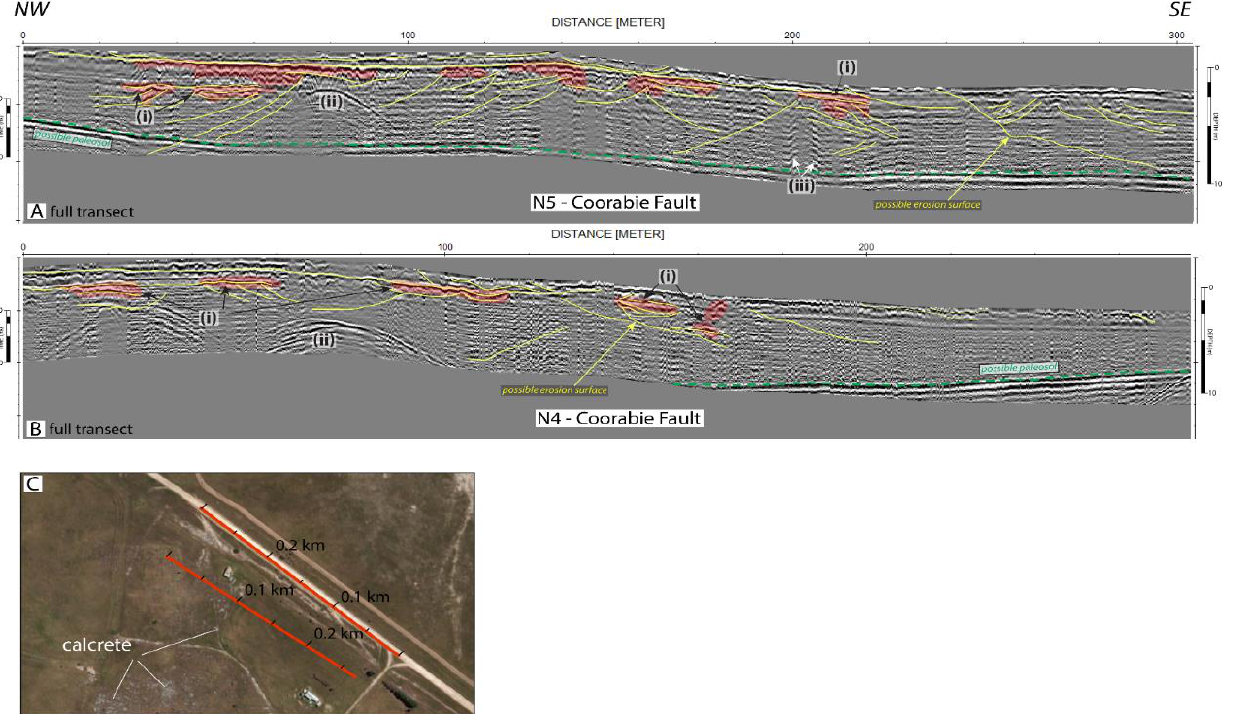
Figure 8. ( A , B ) Full GPR transects N5 and N4 showing interpreted reflectors in yellow; (i) = zones with strong, discontinuous reflectors; (ii) = diffractions caused by old Wookata school building NNE of the transect; (iii) = ‘ringing’ response likely caused a metallic object, i.e., fencing; ( C ) Orthophoto showing the GPR transects in relation to the old school building and other infrastructure.